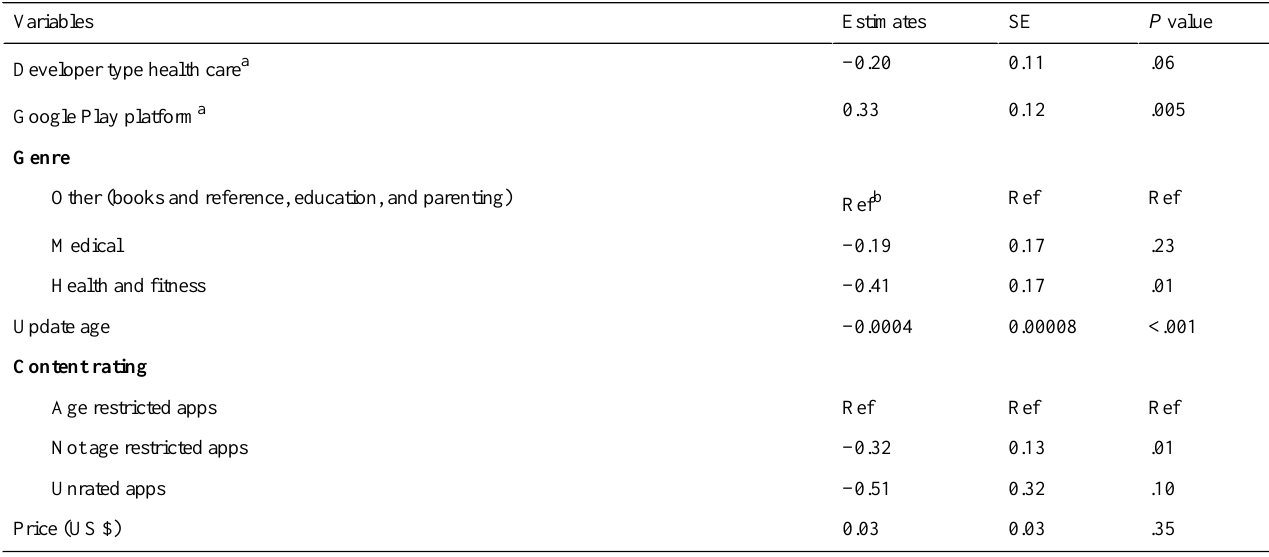
Table 3. Multivariable linear regression for factors associated with standardized user ratings (N=421).